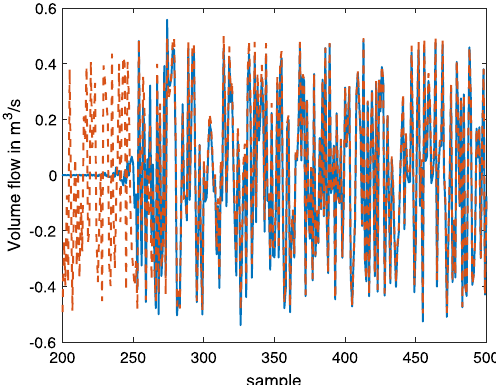
Figure 7. Original source signal (dashed line) and reconstructed source signal (solid line).